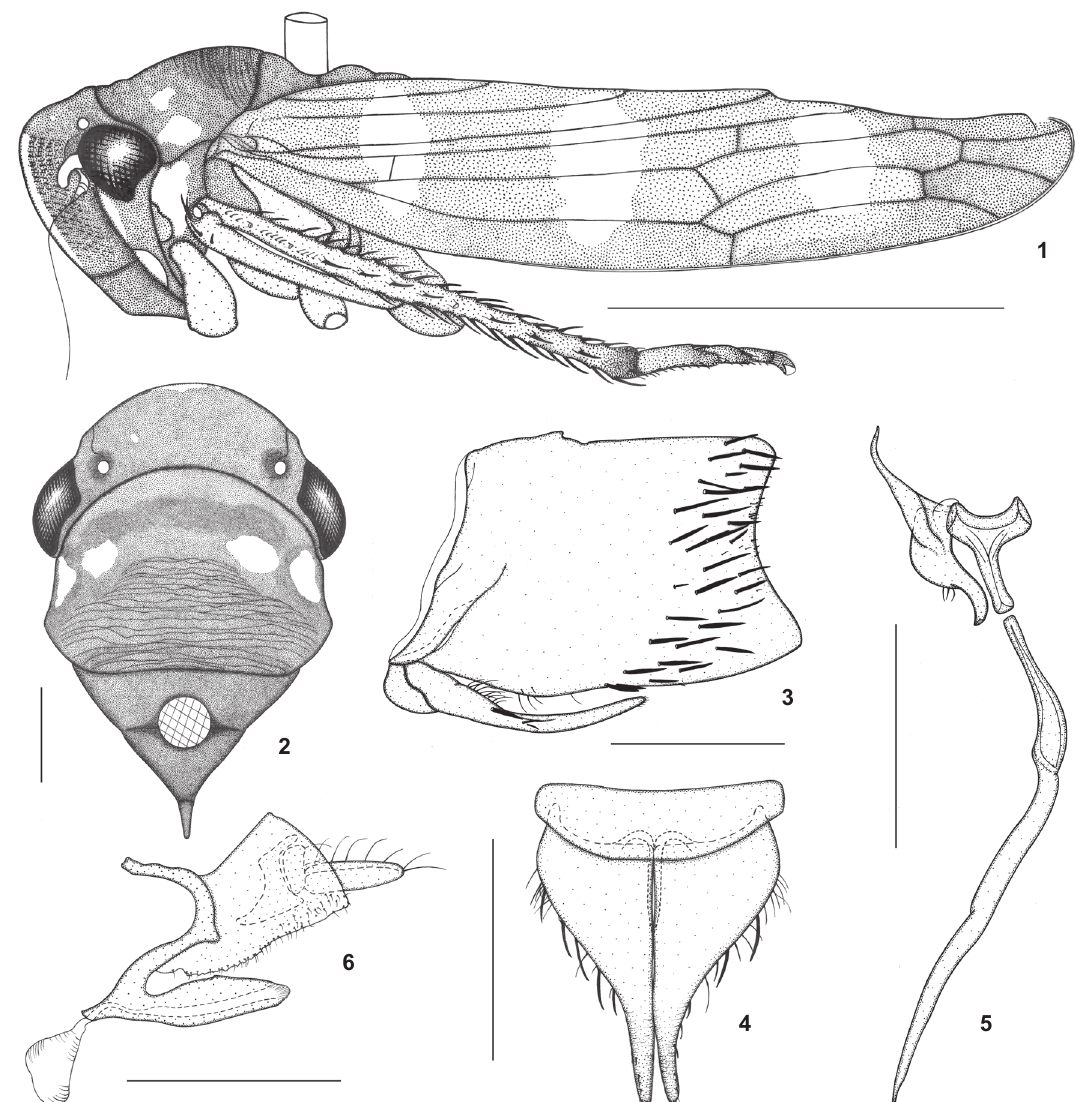
lae on lateral pronotal margins. Abdominal sternite VII (Fig. 7) well produced posteriorly; distal third narrowed, forming dis- tinct median lobe; posterior margin convex, round, without median dentiform